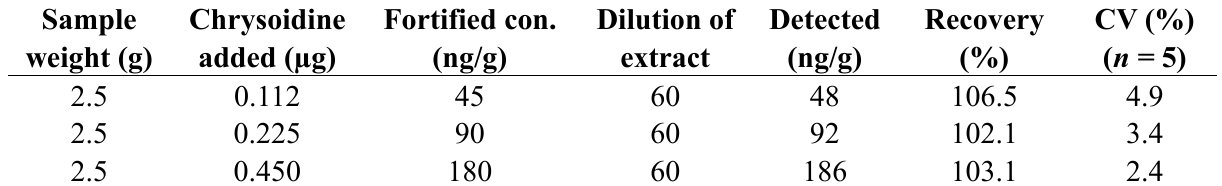
Table 3. Recovery of chrysoidine from the fortified samples by